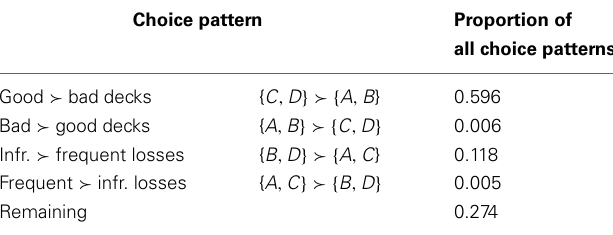
Table 3 | Proportions of choice patterns generated by the PVL-Delta model.